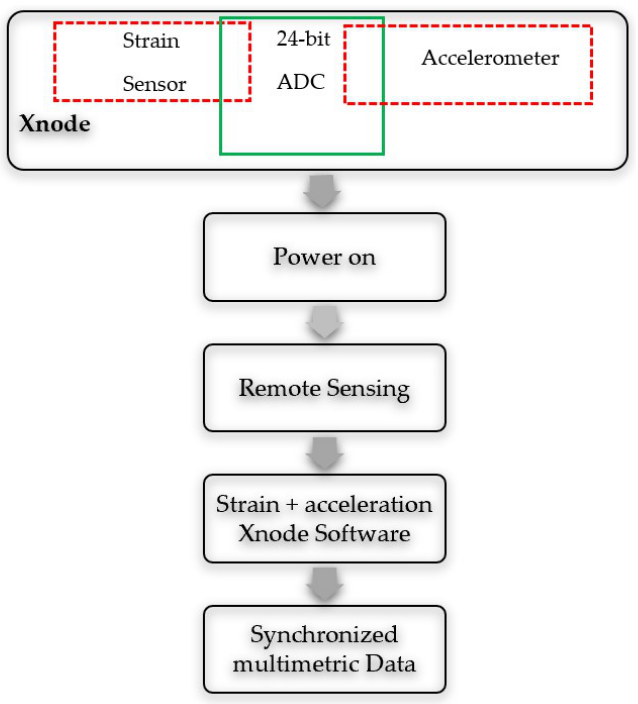
Figure 5. Flowchart of proposed multimetric sensing framework.